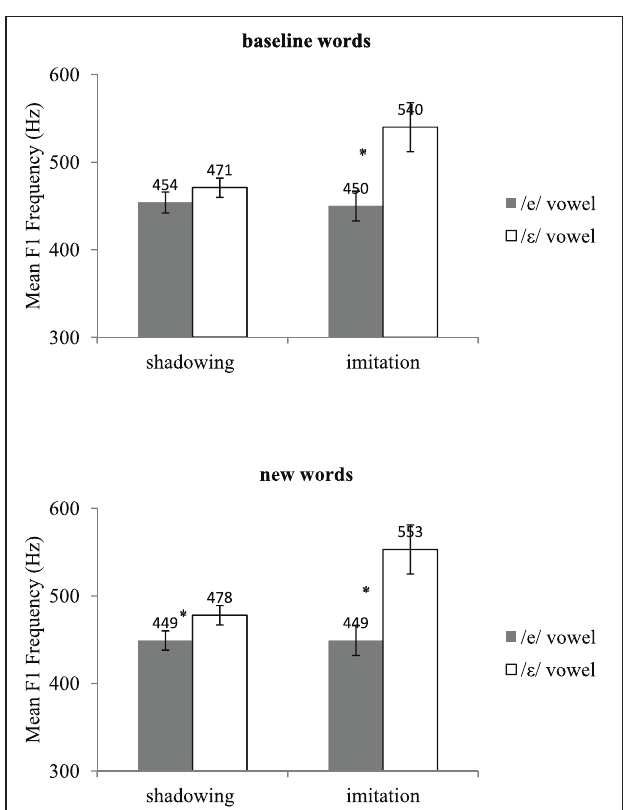
FIGURE 2 | Mean F 1 frequencies and standard errors for the /e/ and / ε / vowels in the shadowing and imitation groups for the test. The label baseline words refers to the words used in the pre-test, and the label new words refers to the words that were used in the test and post-test only. ∗ lndicates a significant effect of the